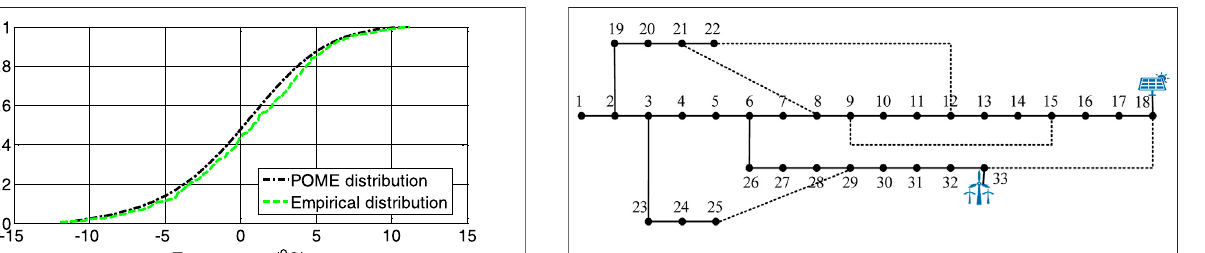
FIGURE 9 | An IEEE 33-bus distribution